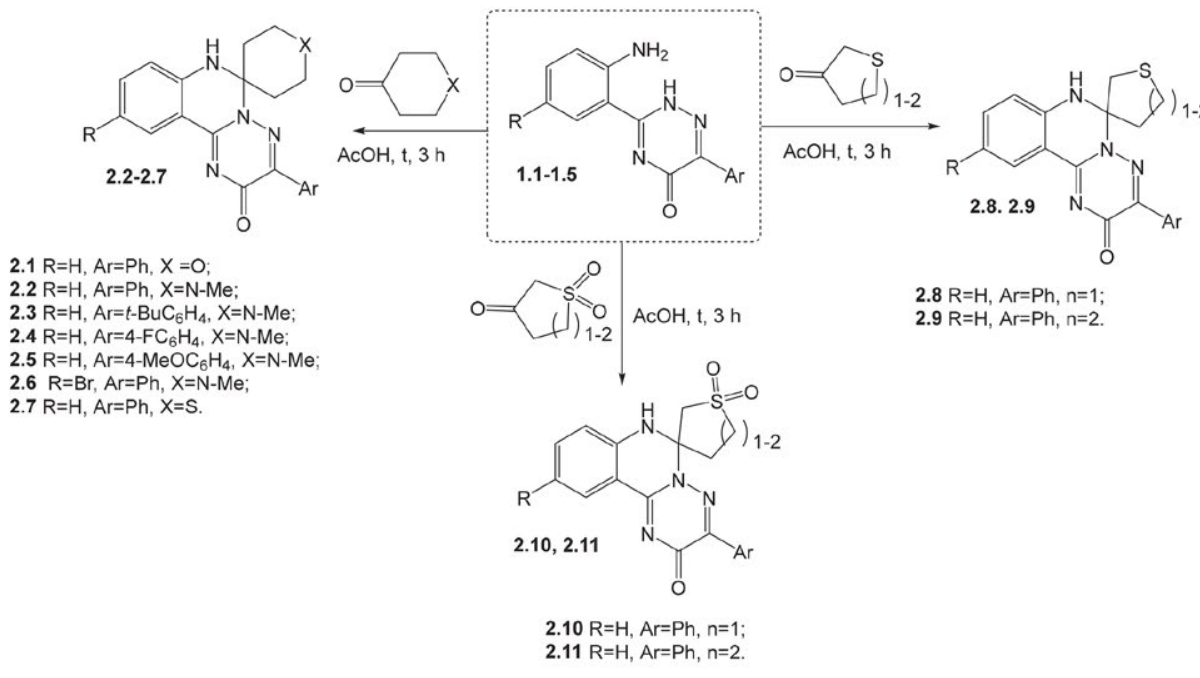
Table 2. Anti-inflammatory activity of synthesized compounds under formalin induced inflammation model Comp. Dosage, mg/kg Increase of the paw volume in 3 h, % Anti-inflammatory activity, % Experimental pathology